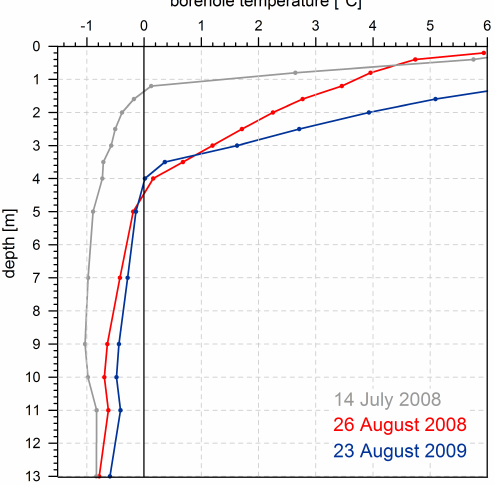
Fig. 15. Borehole temperatures for the Schilthorn at the measure- ment dates (left borehole in Figs. 10 and